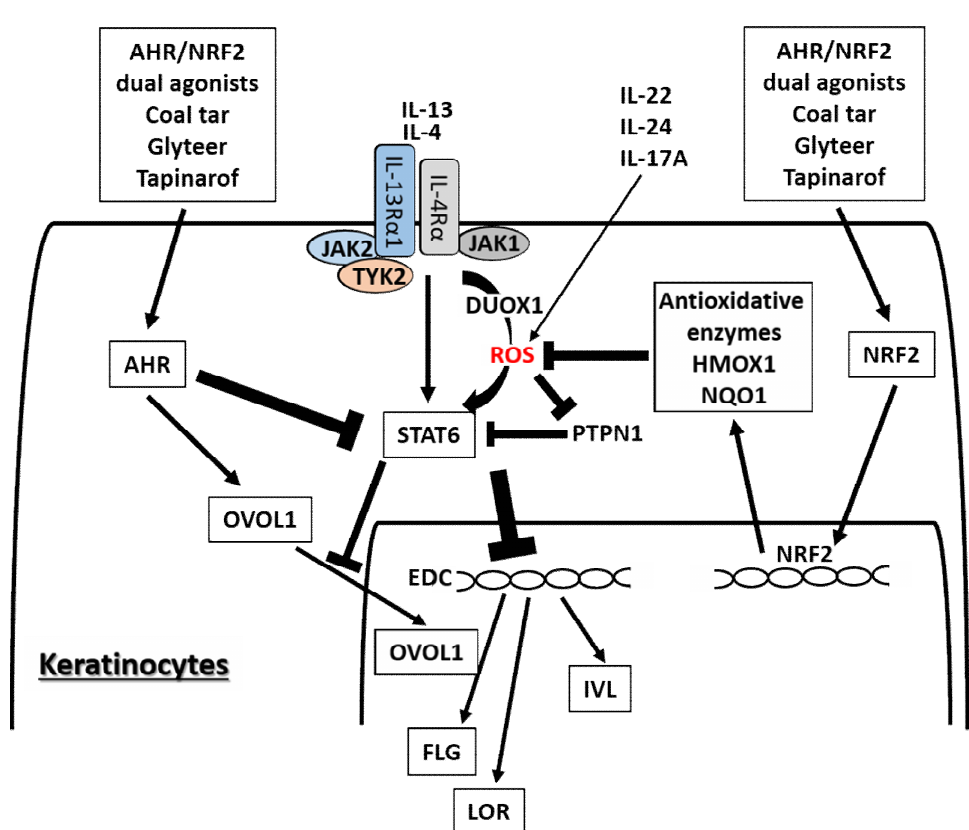
Figure 4. Medicinal AHR / NRF2 dual agonists can restore the IL-4 / IL-13-STAT6-induced downregulation of FLG, LOR, and IVL expression. Coal tar and glyteer activate AHR and inhibit the STAT6 e ff ects partially by increasing the entry of OVOL1 into the nucleus. IL-4 and IL-13 activate dual oxidase protein 1 (DUOX1), generate reactive oxygen species (ROS) production, and promote STAT6 phosphorylation in keratinocytes. On the other hand, the activation or phosphorylation of STAT6 by IL-4 and IL-13 is negatively regulated by protein-tyrosine phosphatase, nonreceptor-type 1 (PTPN1) because PTPN1 dephosphorylates the phosphorylated STAT6. ROS induced by IL-4 and IL-13 inhibit PTPN1 activity and subsequently enhance STAT6 phosphorylation. AHR / NRF2 dual agonists also activate NRF2 and upregulate the antioxidative enzymes such as NAD(P)H quinone oxidoreductase 1 (NQO1) and heme oxygenase 1 (HMOX1), which neutralize the IL-4 / IL-13-induced ROS and downregulate STAT6 phosphorylation by revitalizing the PTPN1 activity. IL-22, IL-24, and IL-17A also induce ROS